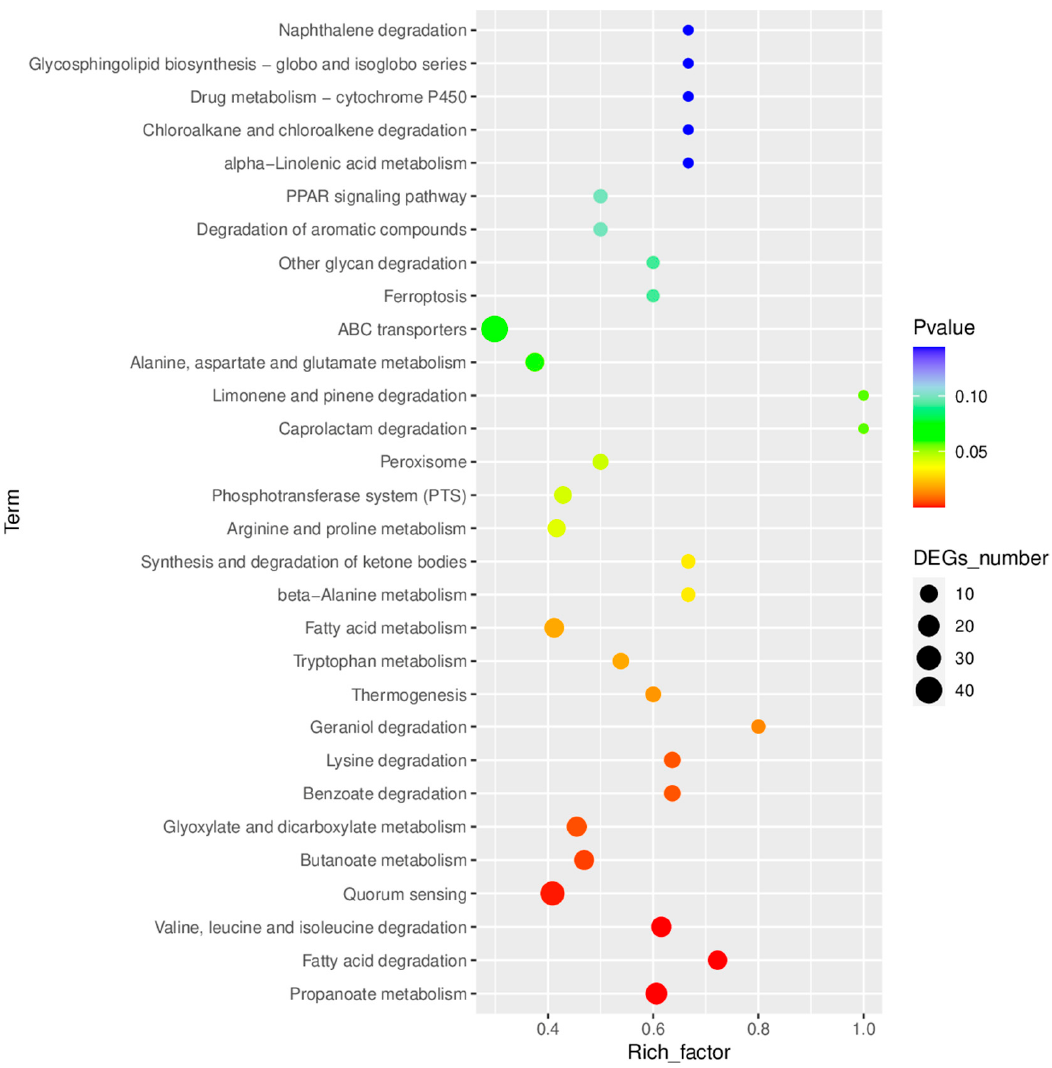
Figure 8. KEGG enrichment map of the di ff erential expression genes.